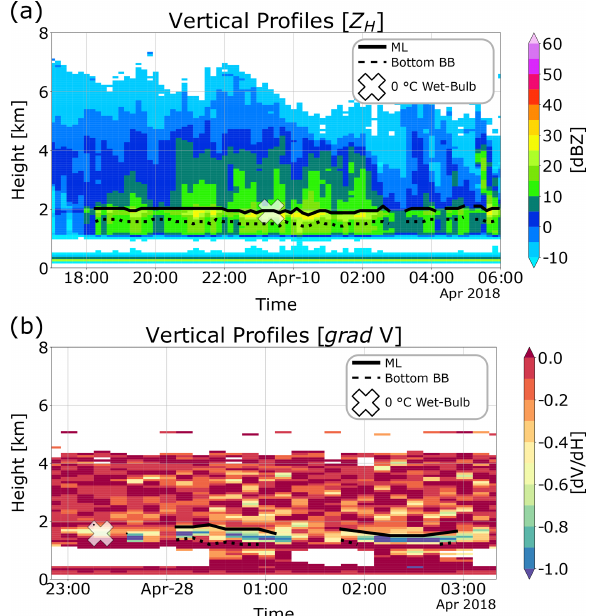
Figure 10. Comparison of the MLA outputs based on the variable P 26 at 90 ◦ elevation angle for two different rain events. Panel (a) shows the detection of the melting layer for a stratiform event dis- played over a height versus time plot of Z H , and panel (b) shows the performance for a convective event displayed over a height versus time plot of grad V .